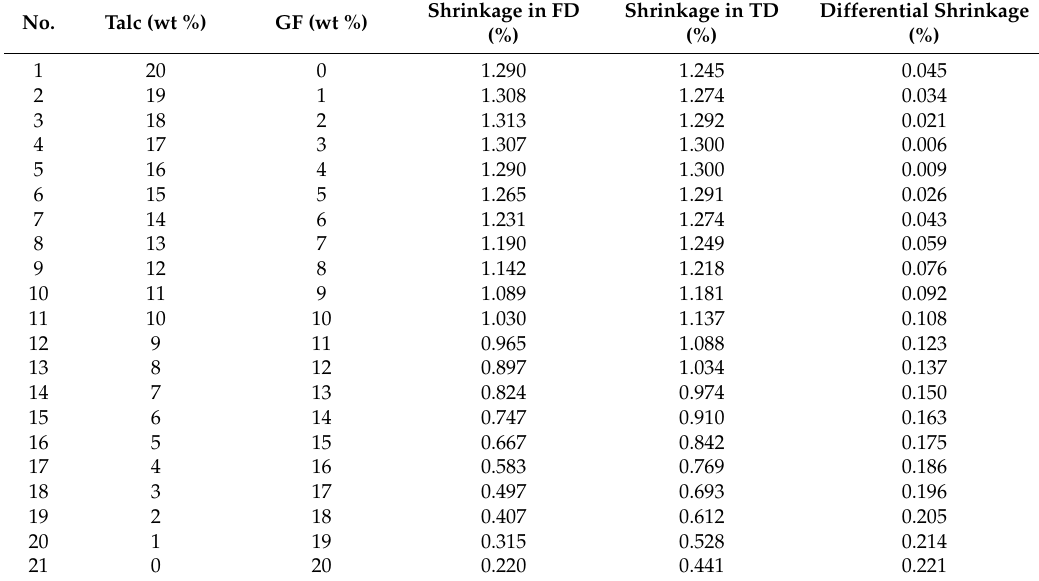
Figure 19. Regression analysis plot for the shrinkage of PP/GF: ( a ) Shrinkage in the flow direction, and ( b ) shrinkage in the transverse direction. Table 12. Shrinkage prediction by regression analysis.